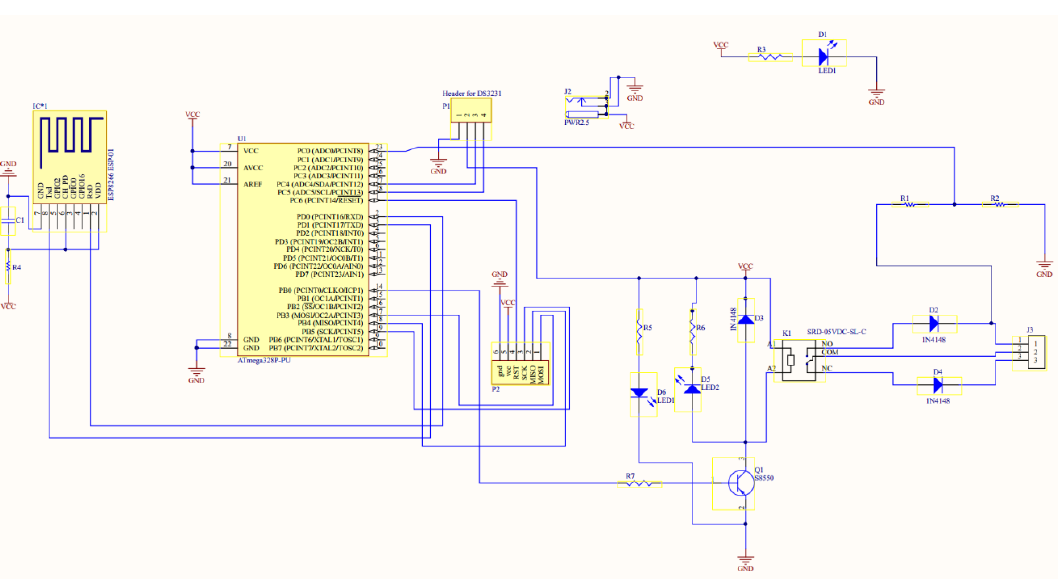
Figure 10. Circuit diagram for the control device.